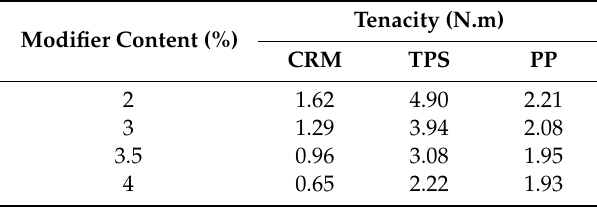
Table 5. Tenacity values of the modifiers.